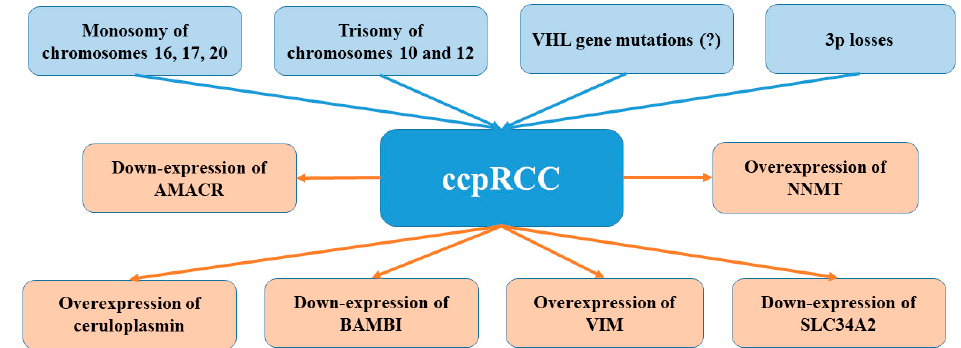
Figure 1. Presents molecular pathways involved in